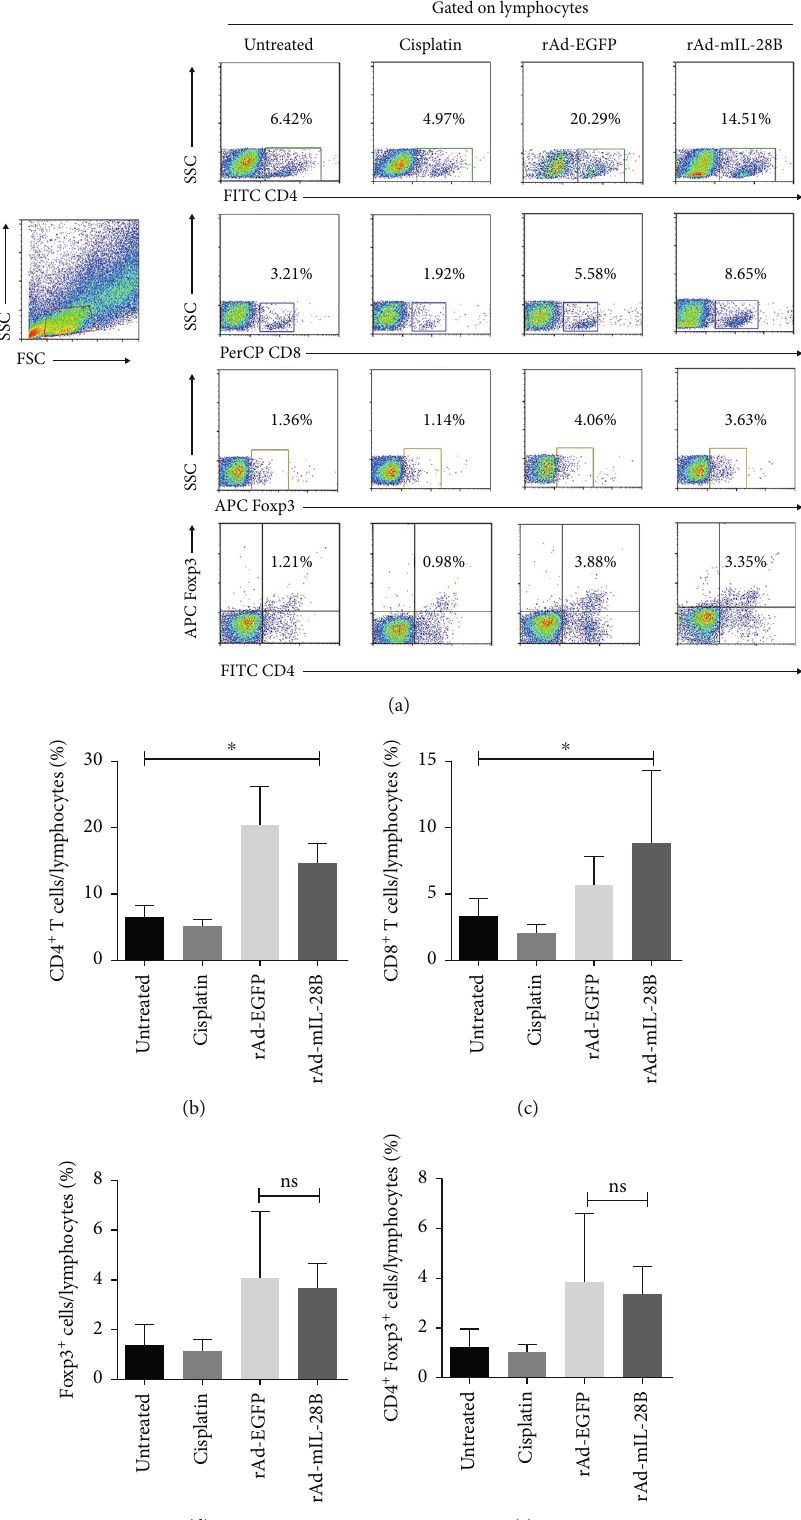
Figure 3: Intratumoral IL-28B gene transfer did not change the tumor-in fi ltrating regulatory T cells. The frequencies of CD4 + , CD8 + , Foxp3 + , and CD4 + Foxp3 + cells in TME. (a) Representative dot plots and percentages of cells bounded by each region are shown in panels. (b) Statistical analysis of the percentages of CD4 + , CD8 + , Foxp3 + , and CD4 + Foxp3 + cells in TME were shown (below panels). Data from one experiment, each performed with three mice, are shown. ∗ P < 0 : 05 ; ns indicated P > 0 : 05